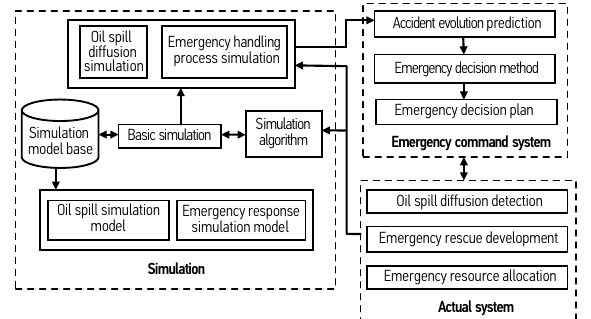
Fig. 1. Framework of DDDAS-based simulation model